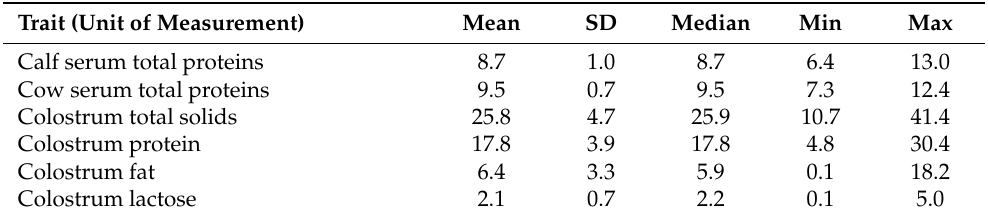
Table 2. Descriptive statistics of cow and calf serum protein concentration (Brix value) and colostrum traits (%).